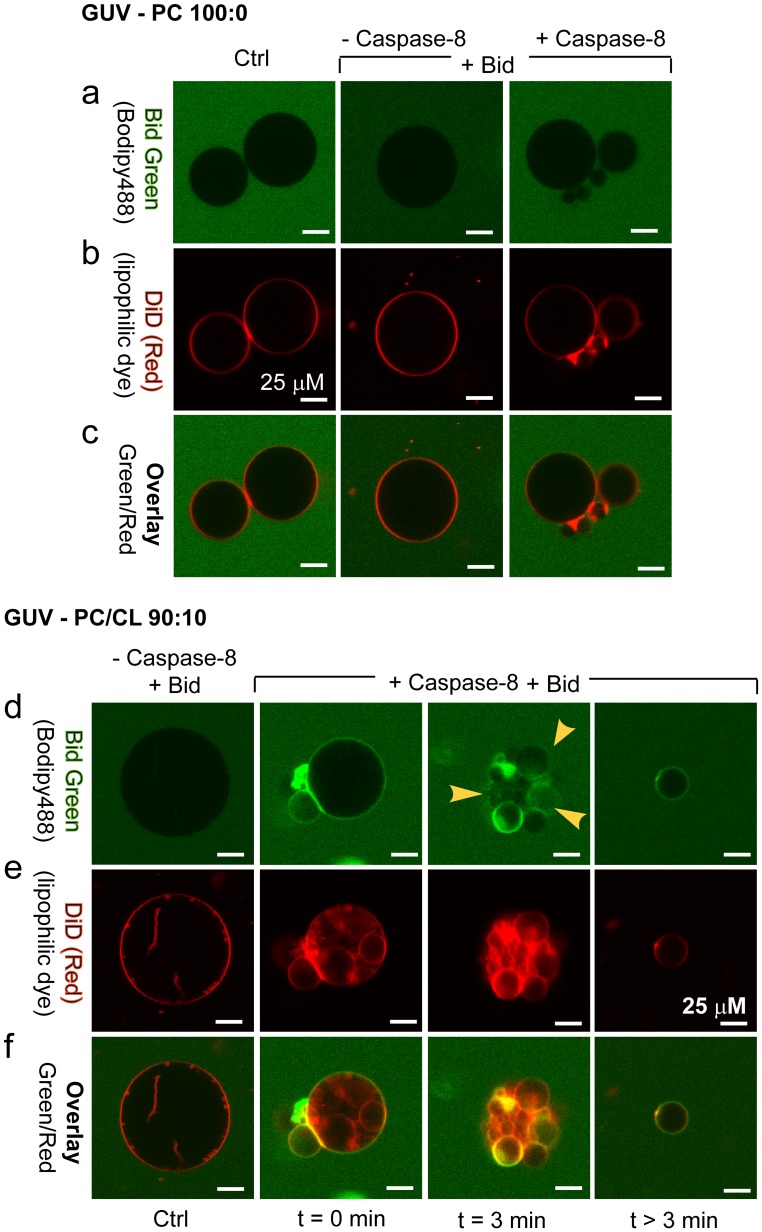
Confocal microscopy study of the binding of Bid and caspase-8 to giant unilamellar vesicles containing cardiolipin.Trios of images (top, middle and bottom) for the same sample: two images obtained with two different detector channels of the microscope, together with an overlay image. DOPC-only (100∶0) vesicles are presented in panels a to c and DOPC/CL (90∶10) vesicles in panels d to f. Top: in a and d, protein binding to GUVs shown in green (this binding only becomes apparent when the green label accumulates at the membrane); middle: the GUV membrane was labelled with 0.05% of the hydrophobic dye DiO, as shown in (b, c) and in red, as shown in (e, f); bottom: overlay of green and red images (c, f). Time is indicated in minutes. The arrows indicate the decrease in GUV fluorescence following the formation of a complex between procaspase-8 and BidAlexa488, resulting in a non-fluorescent tBid.